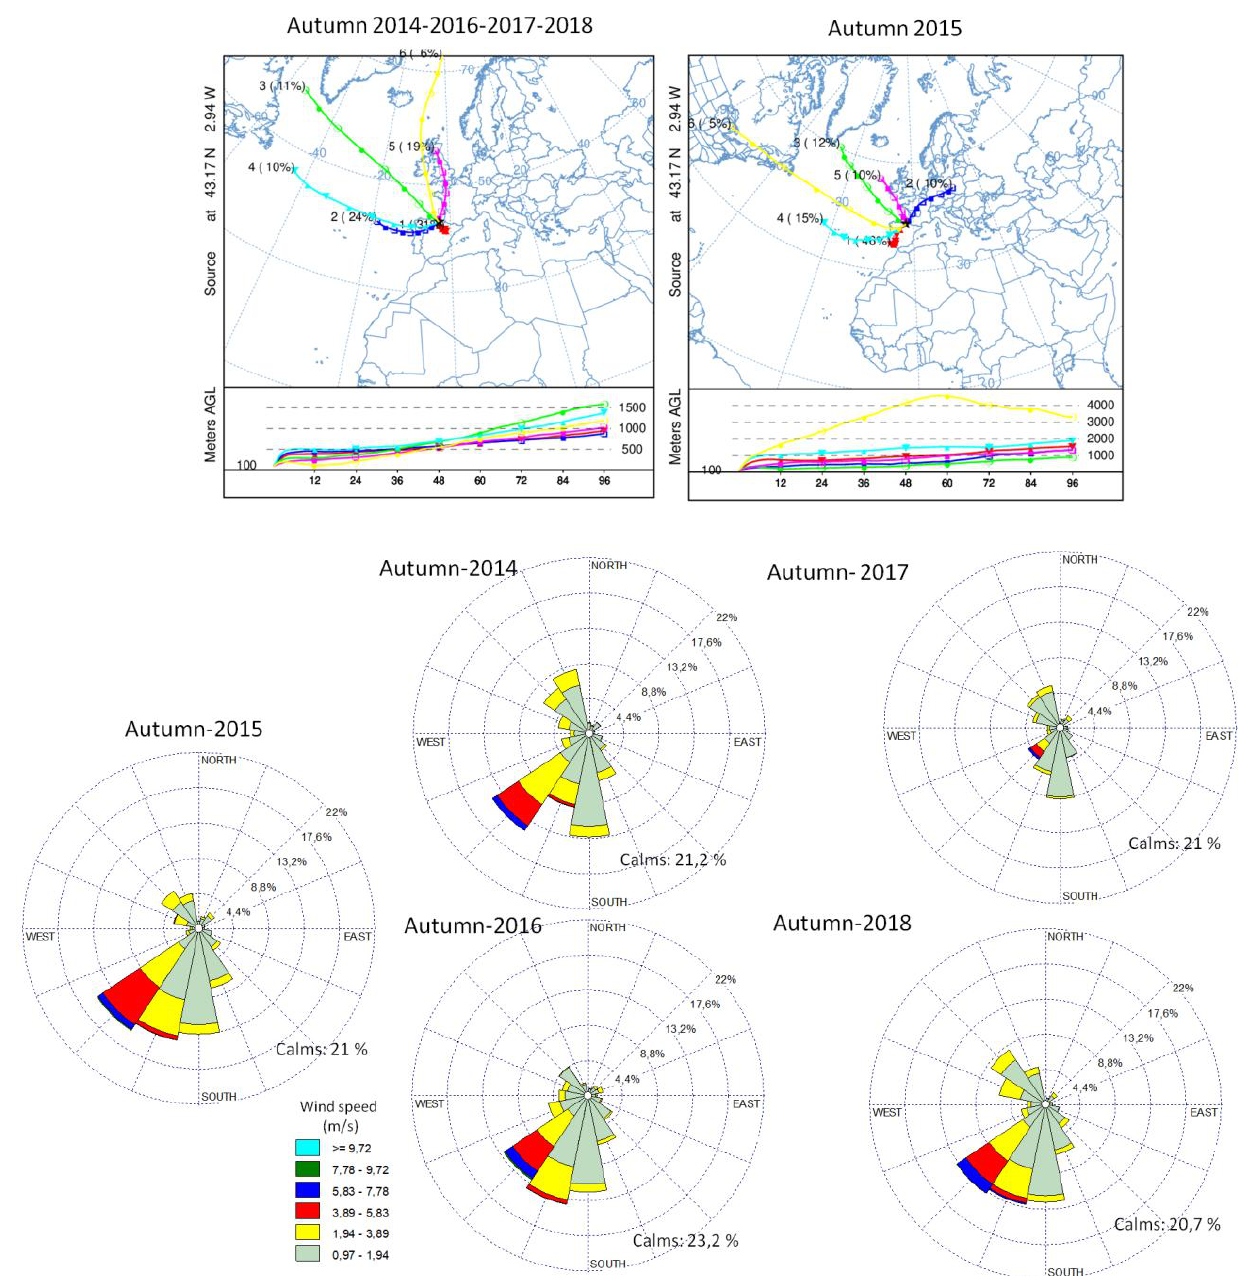
Figure 10. Back-trajectory cluster centers (centroids) obtained at 100 m agl obtained for airflow pattern for each period and wind roses showing the distribution of surface winds (direction and speed) in percentages for each period considered in Bilbao. The left numbers in the centroids are an identification number of the centroid, and the right numbers (in brackets) are the percentages of the complete trajectories occurring in that